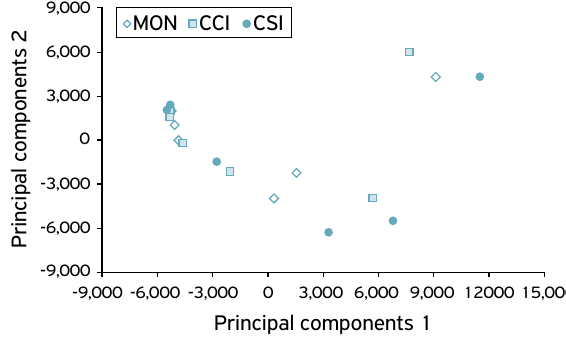
Figure 1. Ordering of the treatments genetically modified maize and conventional maize with and without insecticide sprays in the first two principal components generated in the principal component